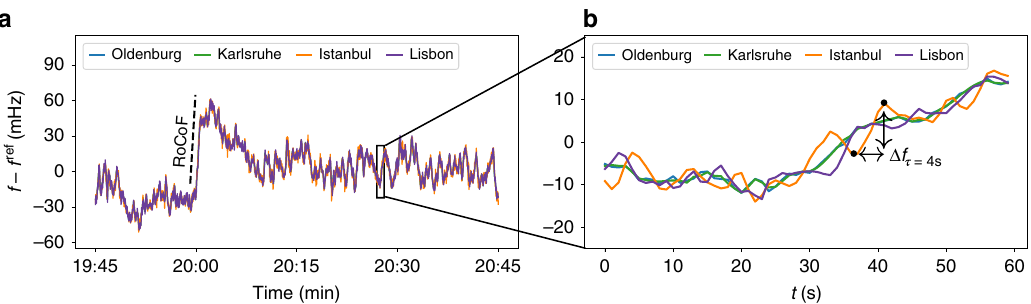
Fig. 5 Synchronised measurements within the Continental European (CE) synchronous area differ on the short timescale. We show a 1 h frequency trajectory recorded at four different sites in the CE area: Oldenburg, Karlsruhe, Lisbon, and Istanbul ( a , b ). We further illustrate the RoCoF (rate of change of frequency) as the slope of the frequency every hour and the increment statistics Δ f τ as the frequency difference between two points with time lag τ . For clarity, we do not include the two Hungarian measurement sites here, which produce similar